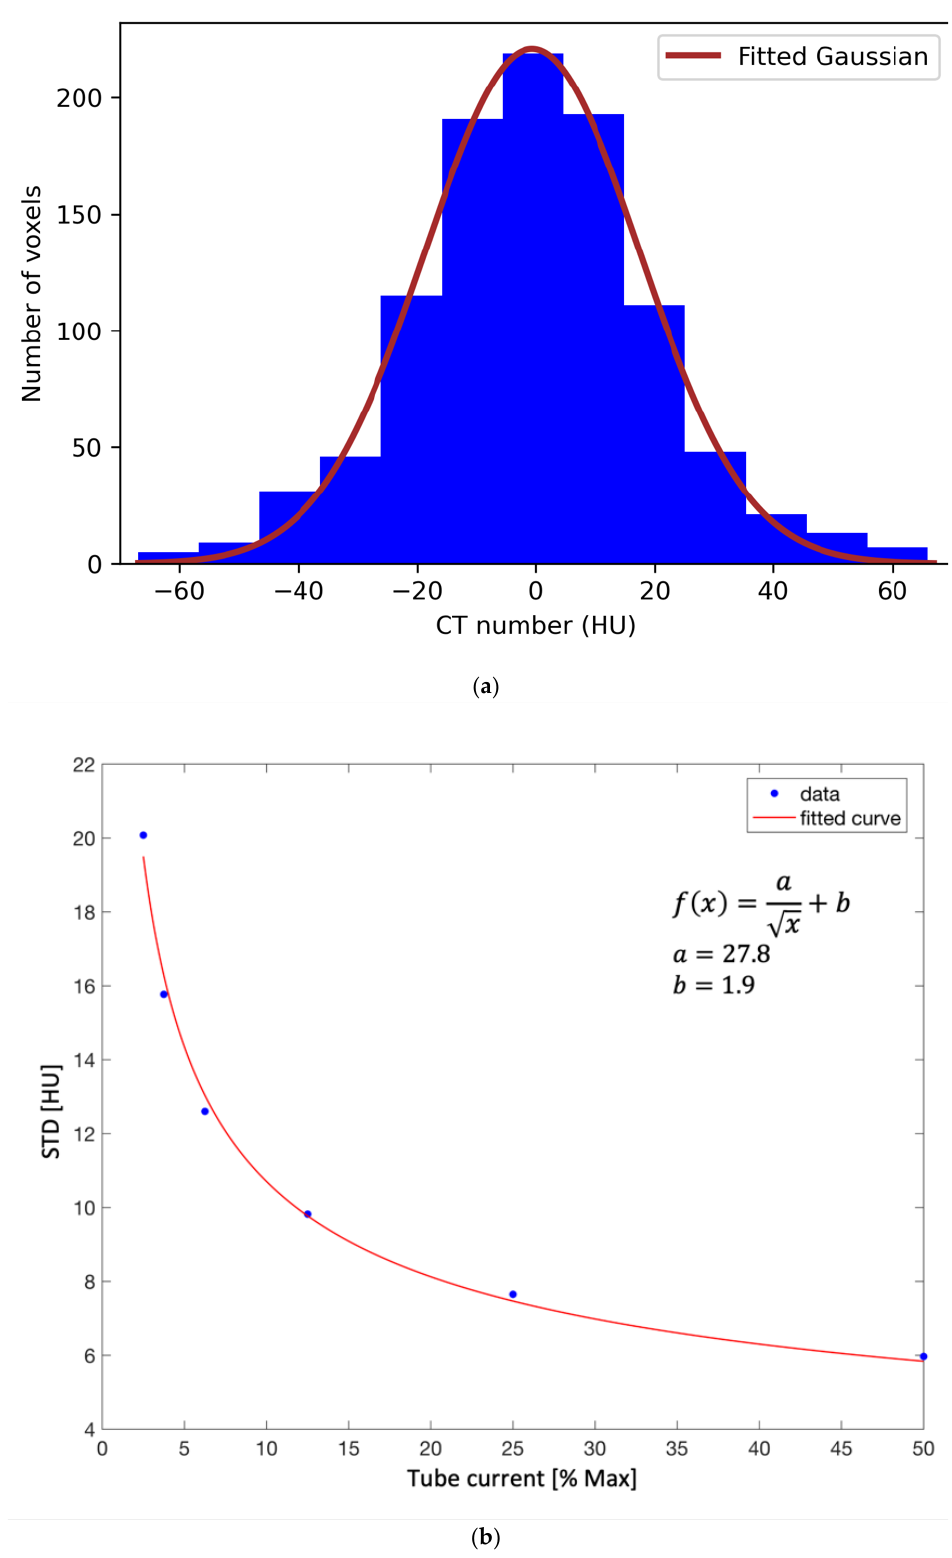
Figure 3. ( a ) Distribution of CT numbers in the lowest-dose CT image of the head phantom corre- sponding to a CT number of 0 HU in the standard-protocol CT image. A Gaussian function is fitted to the histogram. ( b ) Standard deviation (STD) for a CT number of 0 HU as a function of the tube